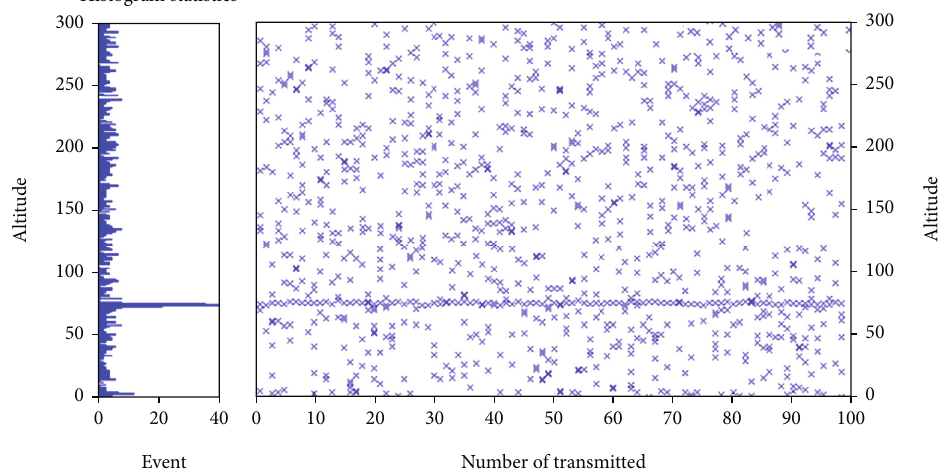
Figure 2: Statistical histogram for time-related back wave signal photon event